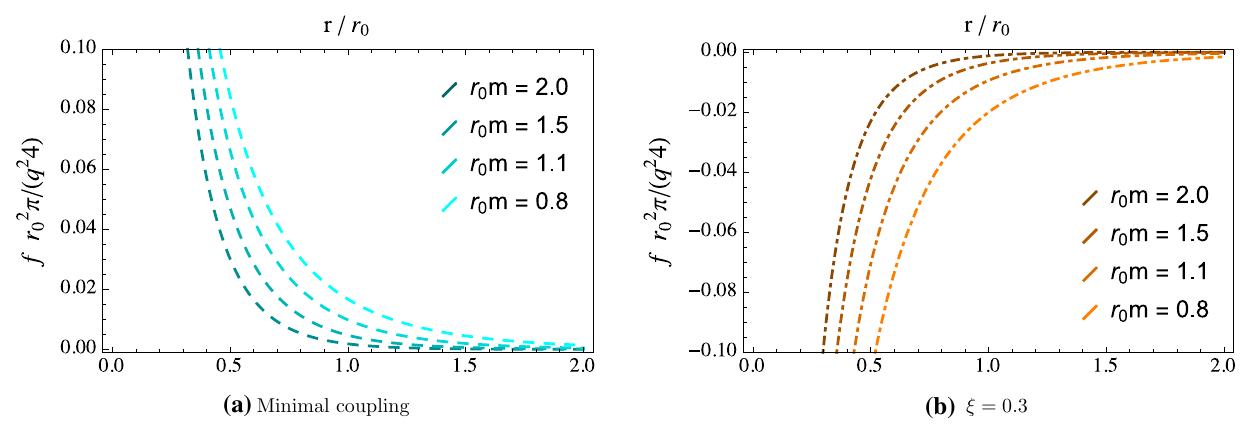
π r 2 f as a function of r / r 0 in cylindrically symmetric wormholes ( ω ∓ = ω ) 0 4 q 2